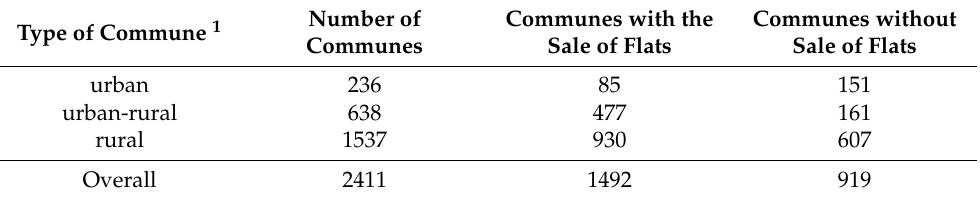
Table 3. Structure of communes by commune type, taking into account the number of flats sold from the state-owned farm resources. Number Type of Commune 1